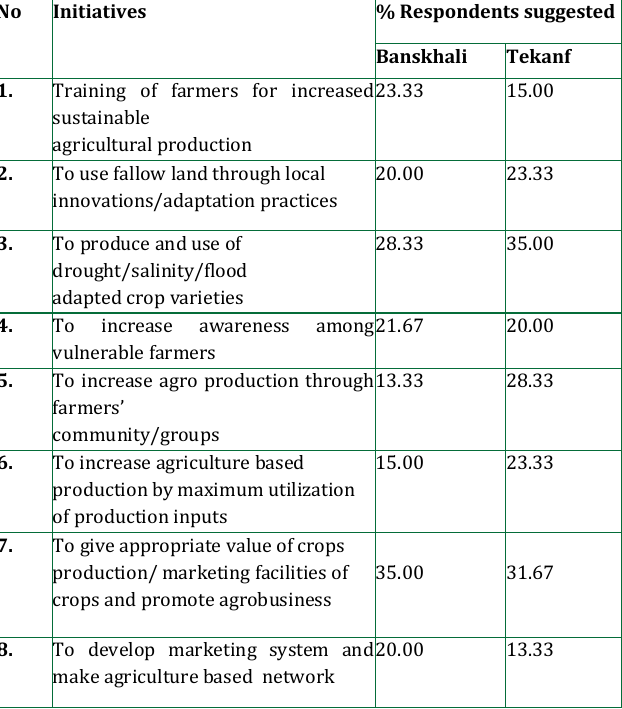
Table 6: Farmers’ opinion/suggestion on the needs of